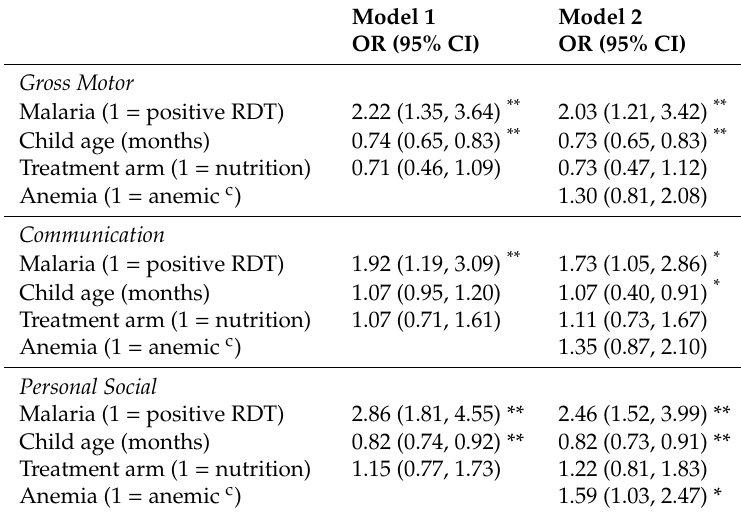
Table 2. Multivariate associations a between the odds of being at risk for developmental delays b